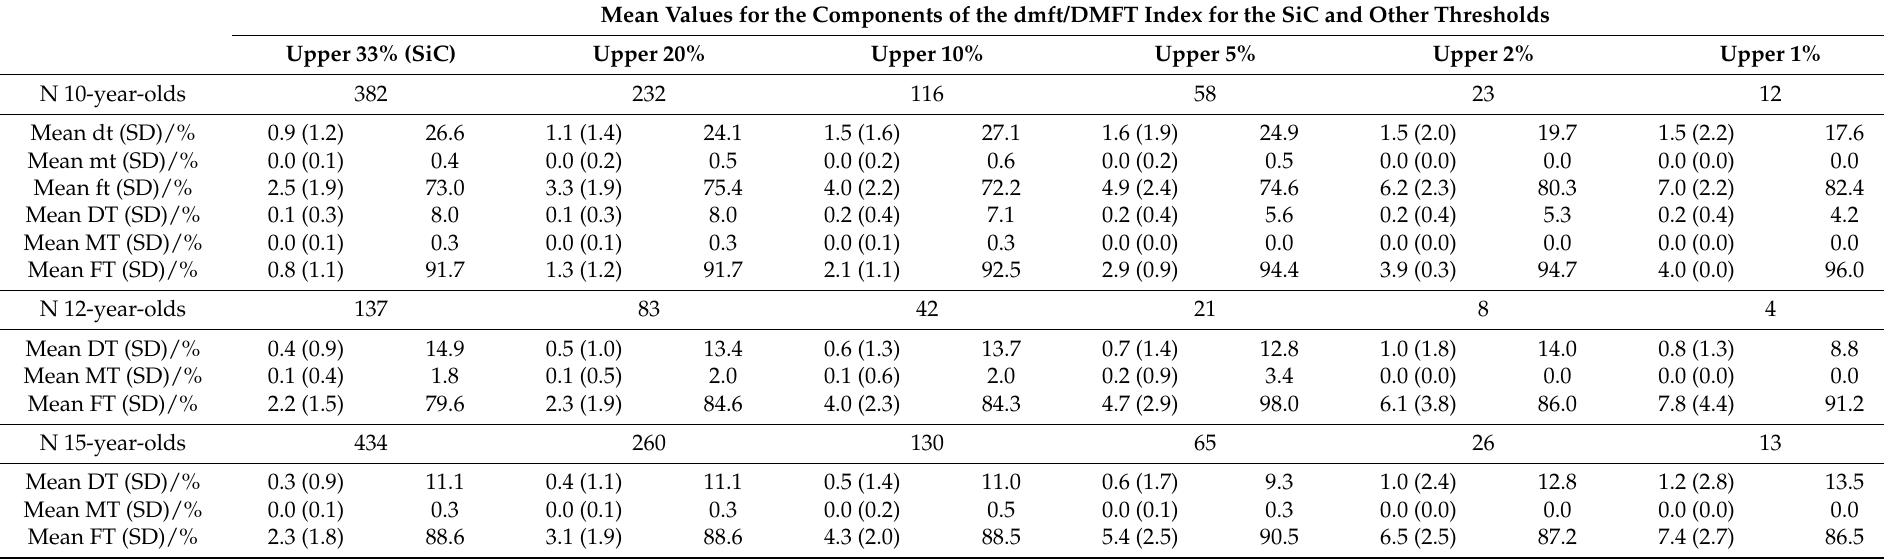
Table 3. Detailed distribution for the components of the dmft/DMFT index in the proportion of most affected patients regarding dmft/DMFT values (upper 33%–1%). Mean Values for the Components of the dmft/DMFT Index for the SiC and Other